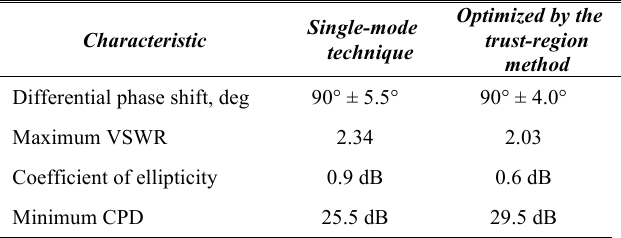
TABLE I. C OMPARISON OF THE CHARACTERISTICS OF NON - OPTIMIZED AND OPTIMIZED WAVEGUIDE POLARIZERS WITHIN THE OPERATING K U - FREQUENCY RANGE